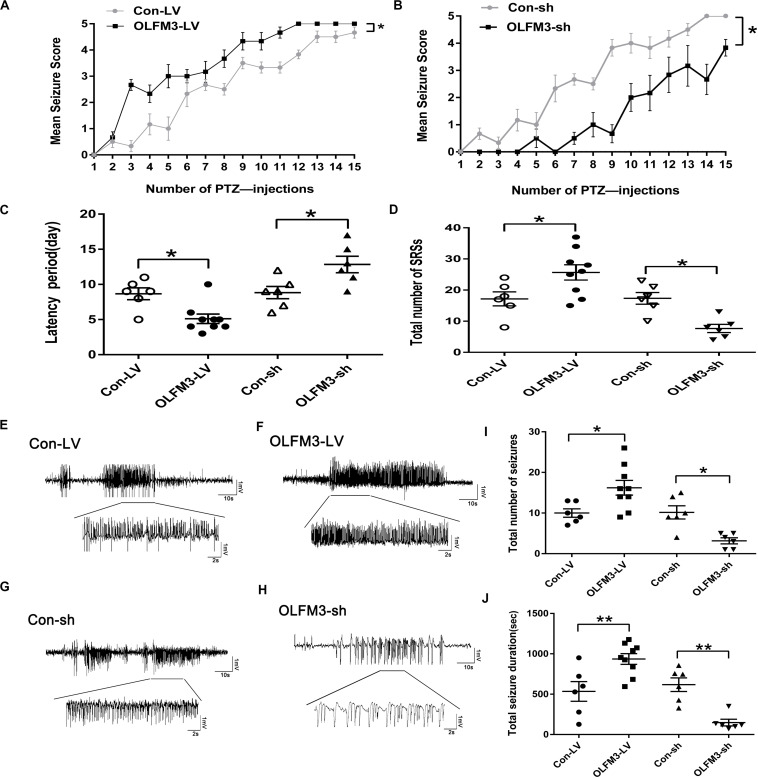
Effects of OLFM3-LV and OLFM3-shRNA on epileptic seizure activity. (A,B) Daily seizure scores were significantly increased in the OLFM3-LV-treated group but were significantly decreased in the OLFM3-shRNA-treated group compared with the corresponding control groups in the PTZ kindling epileptic model (n = 6–9 in each group) (∗P < 0.05). (C) The latency of SRSs in the OLFM3-LV-treated group with KA-induced epilepsy was significantly shorter than in the controls, while the latency in the OLFM3-shRNA-treated group was significantly longer than in the controls (n = 6–9 in each group) (∗P < 0.05). (D) Mice injected with OLFM3-LV had more SRSs than the control group. However, mice injected with OLFM3-shRNA had less frequent SRSs than control mice (n = 6–9 in each group) (∗P < 0.05). (E–H) Representative electrical epileptiform discharges in each group (Con-LV, OLFM3-LV, Con-sh, and OLFM3-shRNA). (I,J) EEG recordings showed that the mice injected with OLFM3-LV had a significantly increased frequency and total duration of electrical epileptiform discharges compared with the mice injected with Con-LV, while the frequency and total duration of the electrical epileptiform discharges were significantly decreased in the OLFM3-shRNA-treated group compared with the control group (n = 6–9 in each group) (∗P < 0.05, ∗∗P < 0.01).